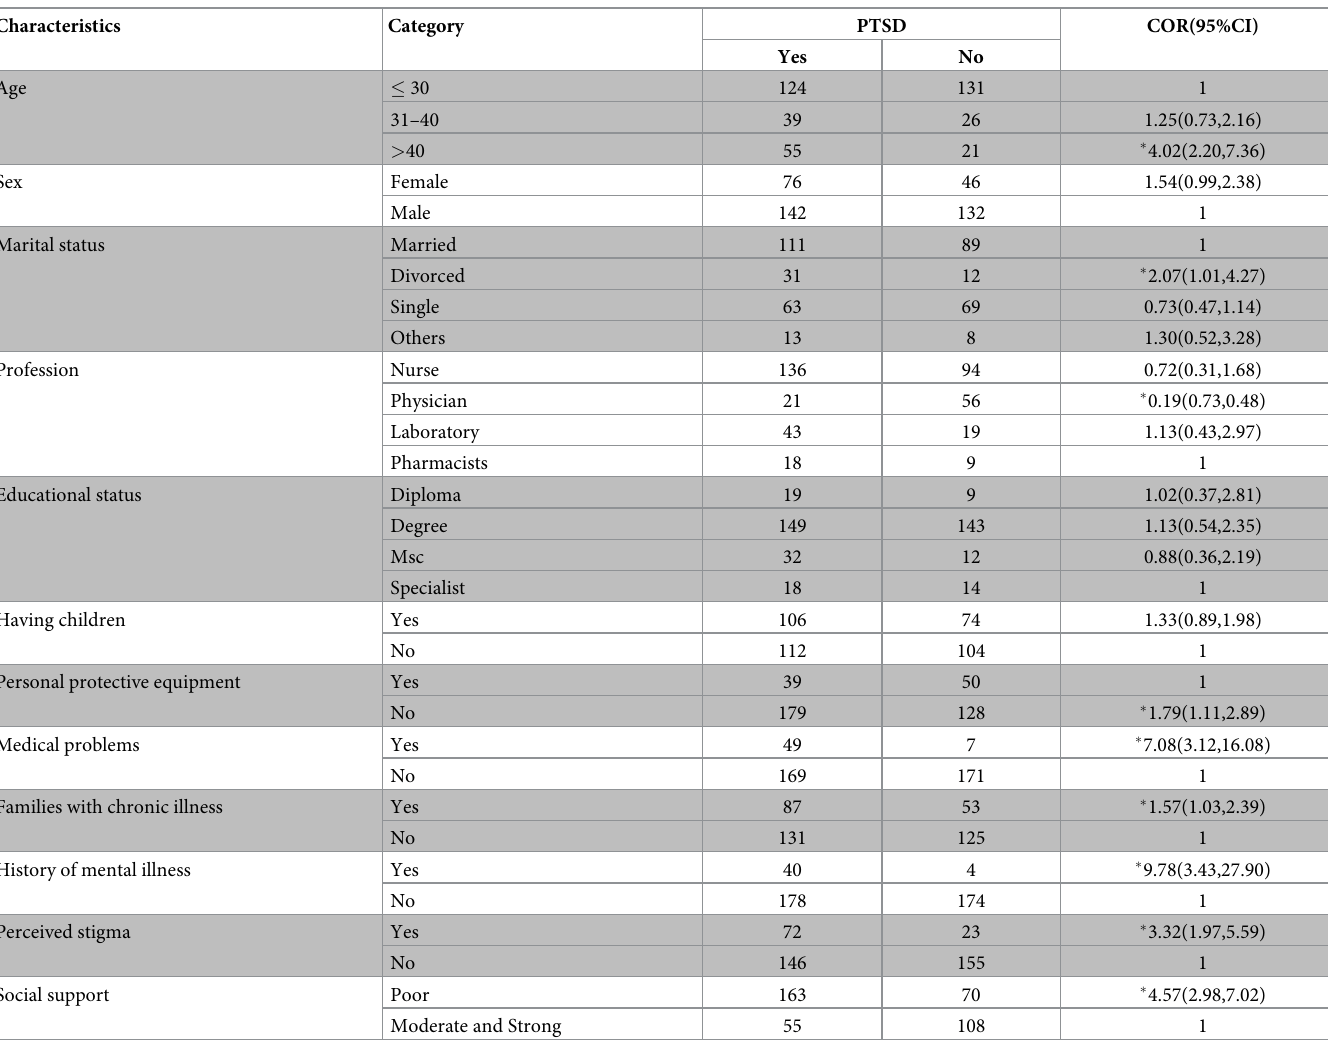
Table 3. Bivariate analysis showing factors associated with PTSD on health care providers in South Gondar hospitals, Ethiopia,